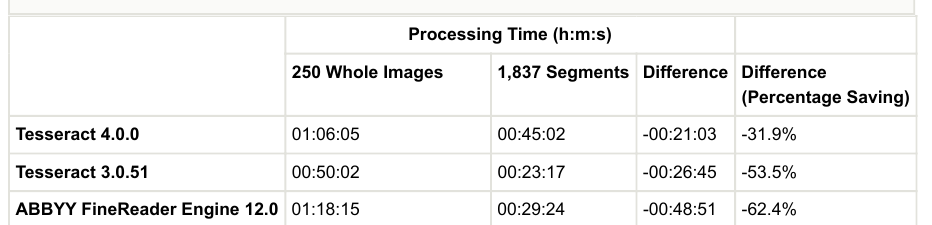
Processing times for OCR programs using whole images and